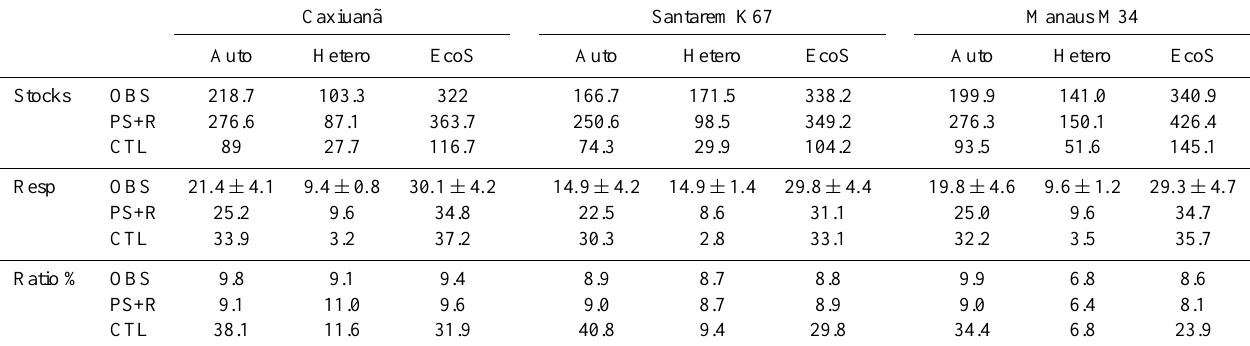
Table 5. Mean annual autotrophic and heterotrophic carbon stocks and respiration flux deduced from the synthesis of observations (OBS) done by Malhi et al. (2009) and simulated by ISBACC (simulations CTL and PS + R) at Caxiuana, K67 and M34. Stocks are in tCha − 1